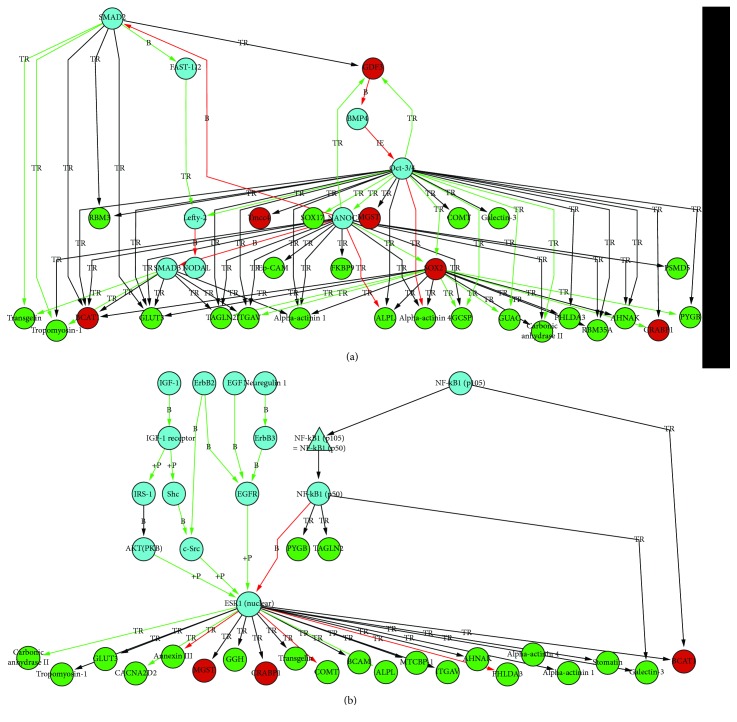
Results of network analysis: differentially regulated proteins from the SILAC approach are indicated in green (TCam-2) or in red (NTERA-2). Blue proteins represent proteins that were added from the Metacore database as potentially linked to the proteins from the SILAC analysis which are involved e.g. in gastrulation, endoderm development or formation of primary germ layer (a) and which are involved, e.g., in mammary gland development or fibroblast growth factor receptor signaling pathway (b). TR: transcription regulation; +P: phosphorylation; B: binding.